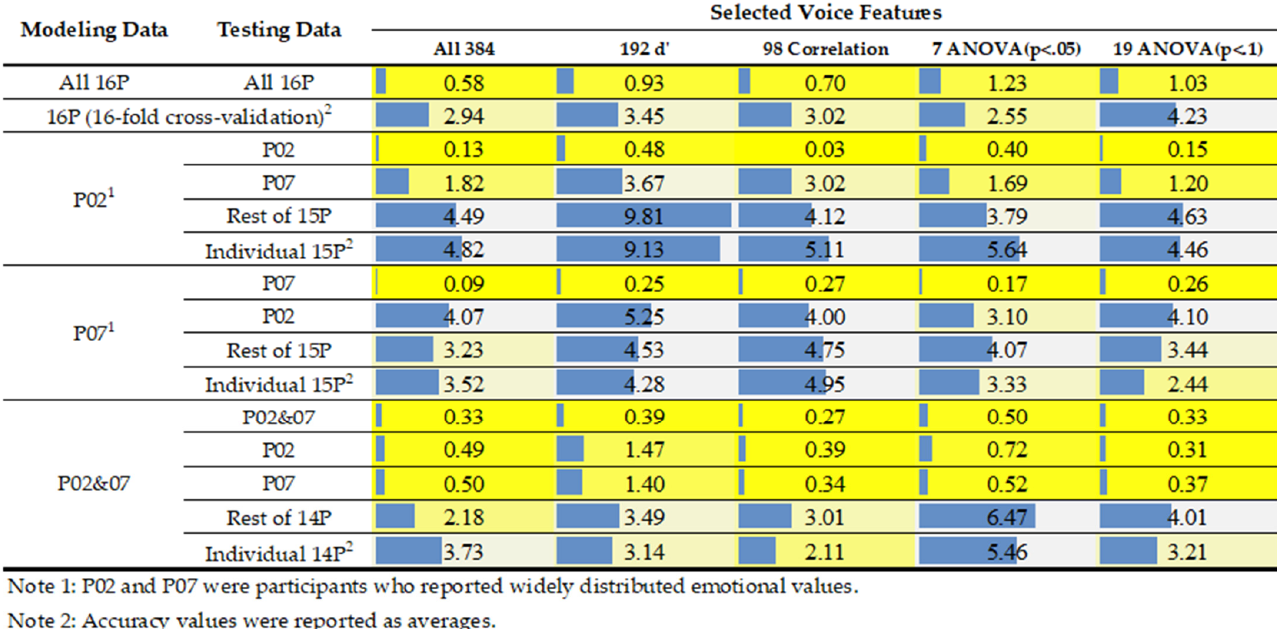
Figure 5. The comparison of modeling MSE of various data set. A longer blue bar indicates a relatively higher value, and a brighter yellow shade indicates a better modeling performance.